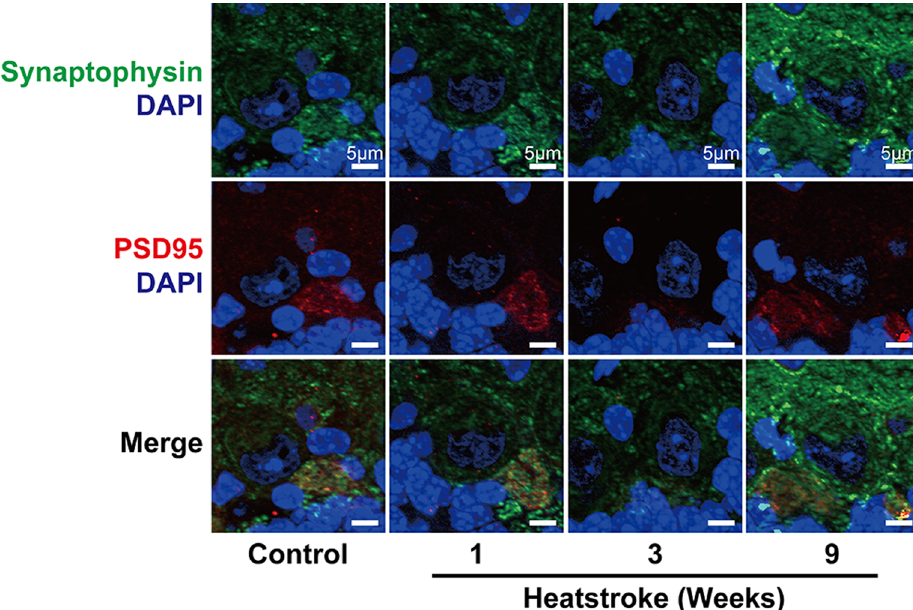
Figure 5. Expression of postsynaptic density-95 and synaptophysin around Purkinje cells. To estimate synaptic connections, pre- (synaptophysin, green) and postsynaptic (PSD95, red) markers were co-stained in the cerebellum and were observed with higher magnification images. Both postsynaptic density 95 and synaptophysin immunoreactions in the Purkinje cell layer appeared to have attenuated 3 weeks after heatstroke and intensified again after 9